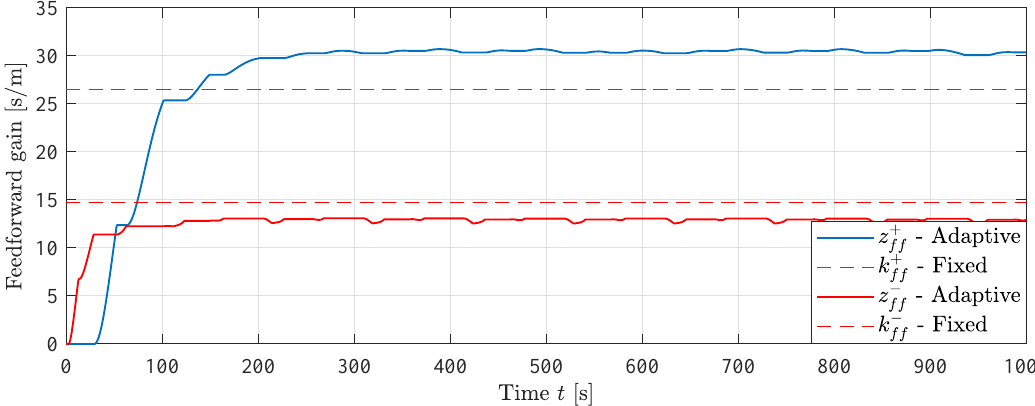
Figure 24. Feedforward states during MIT-rule feedforward experiment, γ = 200 s · m − 3 .